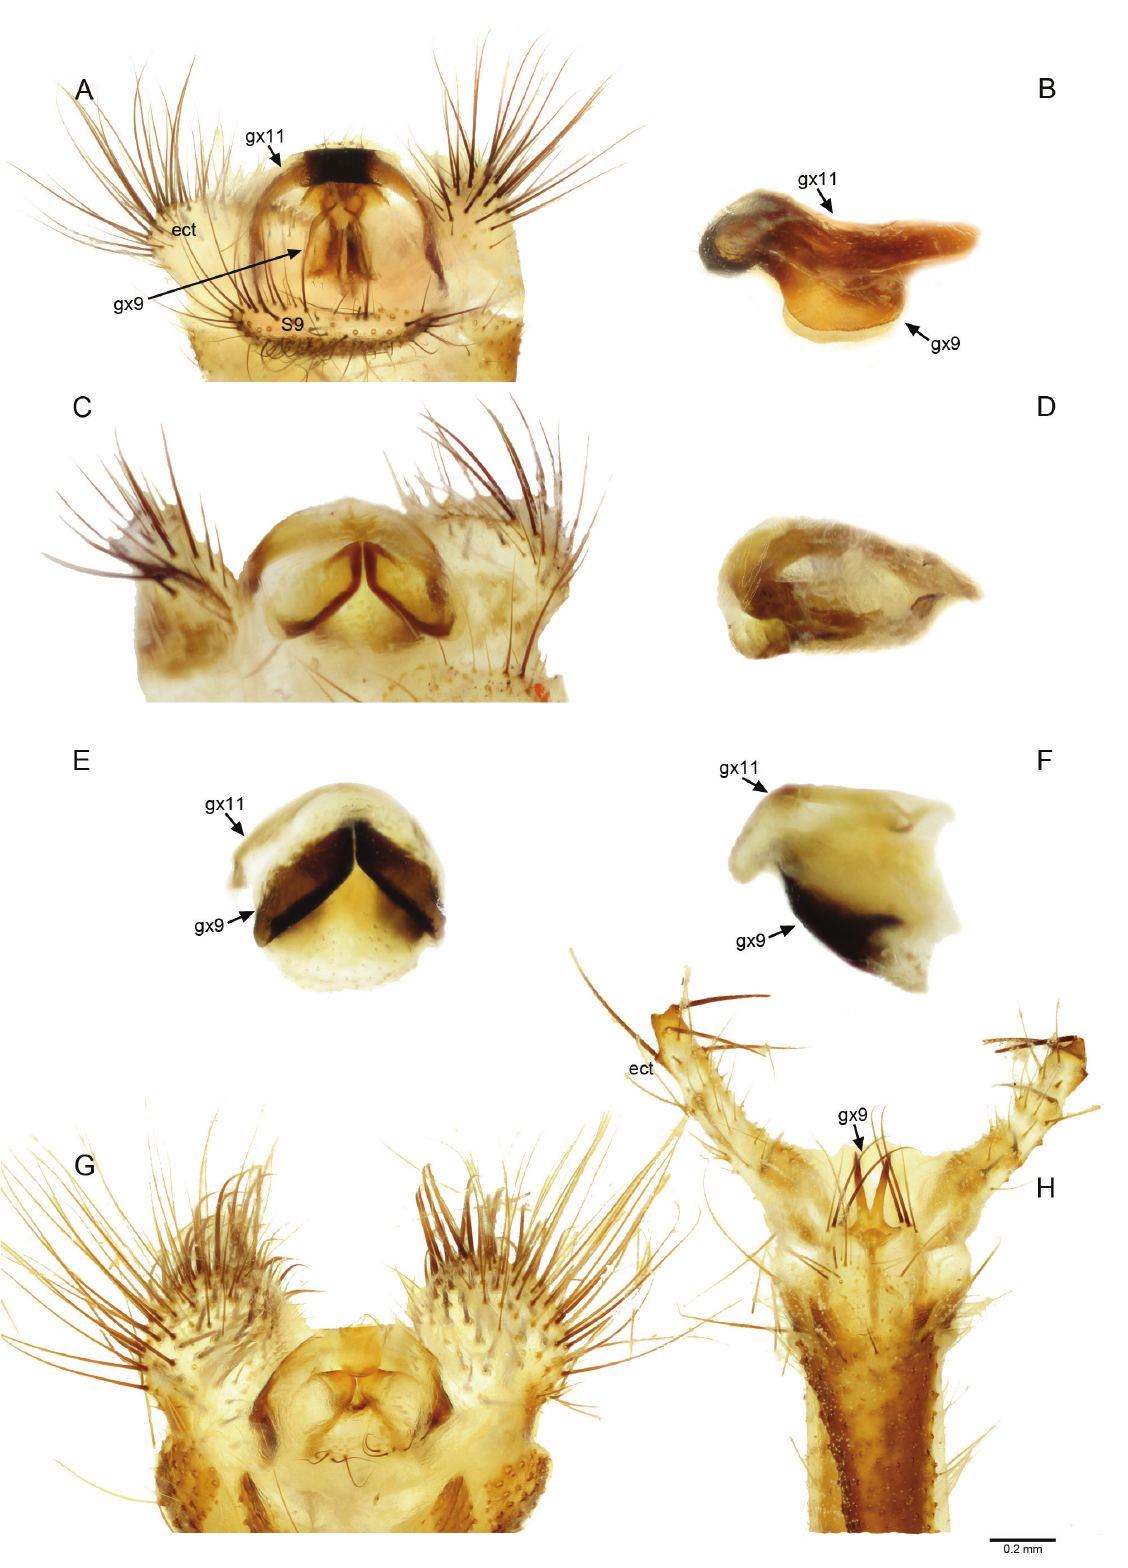
Figure 8. Male genitalia of Nemoleontini, complex of gonocoxites 9 + gonocoxites 11 sensu U. Aspöck and H. Aspöck (2008) (=gonarcus-parameres complex sensu H. Aspöck et al. 1980). A–B Gymnocnemia variegata [Greece, Corfu], A apex of abdomen, ventral view, B gx 9 + gx 11, lateral view; C–D Megistopus lucasi [Italy, Sardinia], C apex of abdomen, ventral view, D gx 9 + gx 11, lateral view; E–F Megistopus flavicornis [France, Gard], gx 9 + gx 11, E ventral view, F lateral view; G Nedroledon iranensis (Hölzel, 1972) [Iran], apex of abdomen, ventral view; H Nemoleon notatus [Italy, Sardinia], apex of abdomen, ventral view. Abbre- viations: ect – ectoproct, gx9 – gonocoxite 9, gx11 – gonocoxite 11, S9 – sternite